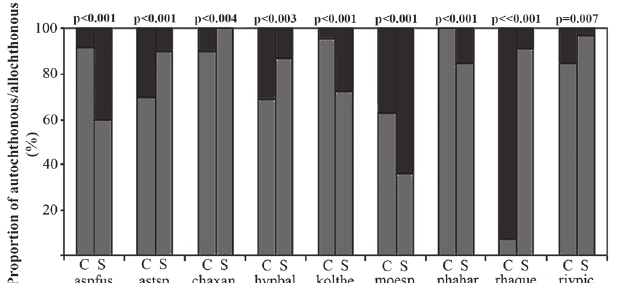
Fig. 6. Proportion of autochthonous feeding items (black) and allochthonous (gray) with respect to the rainy (C) and dry (S) seasons for the fish species that presented this significant variation. Species abbreviations: Aspidoras fuscoguttatus (aspfus), Astyanax sp. (astsp), Characidium xanthopterum (chaxan), Hasemania sp. (hassp), Hyphessobrycon balbus (hypbal), Heptapterus sp. (hepsp), Knodus moenkhausii (knomoe), Kolpotocheirodon theloura (kolthe), Moenkhausia sp. (moesp), Phalloceros harpagos (phahar), Planaltina myersi (plamye), Rhamdia quelen (rhaque) and Rivulus pictus